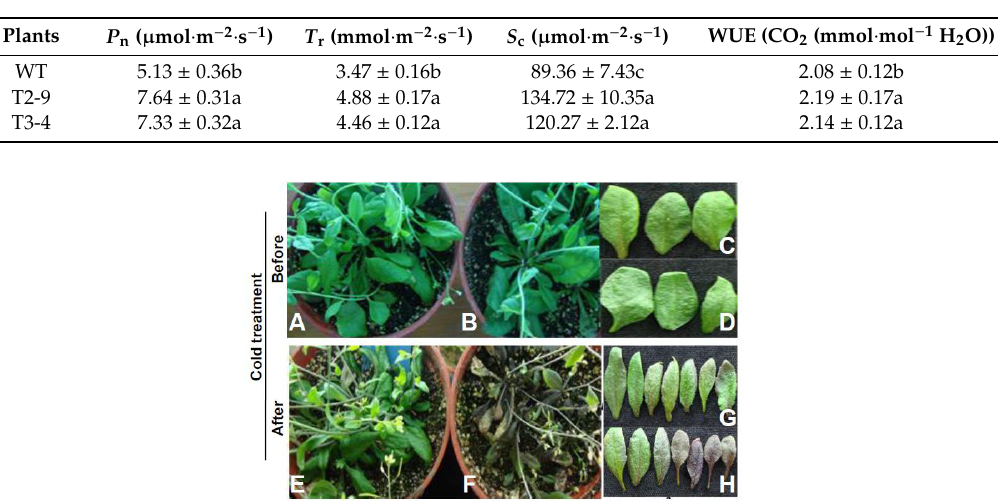
Table 2. The e ff ects of cold treatment on the net photosynthetic rate ( P n), transpiration rate ( T r), stomatal conductance ( S c), and water use e ffi ciency (WUE) of WT and transgenic plants. Data were shown as mean ± SD; di ff erent letters presented significant di ff erences among columns ( p < 0.05). WT presented wild-type plants.